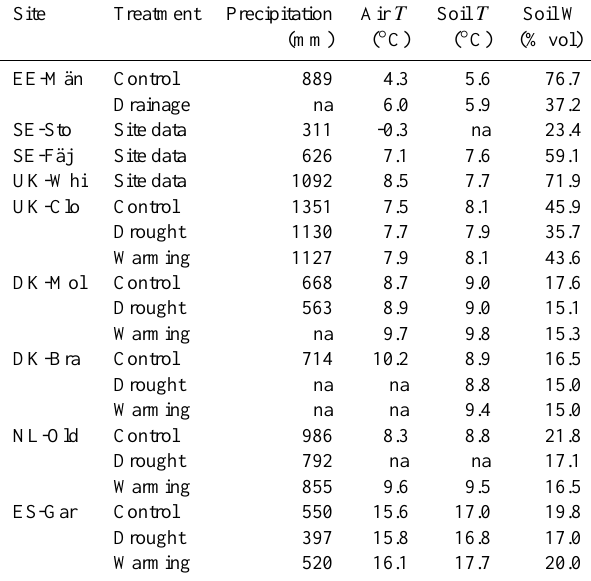
Table 2. Annual precipitation, air temperature (Air T ), soil tem- perature (Soil T ) and soil water content (Soil W) during the study period at the nine experimental sites depending on treatment.